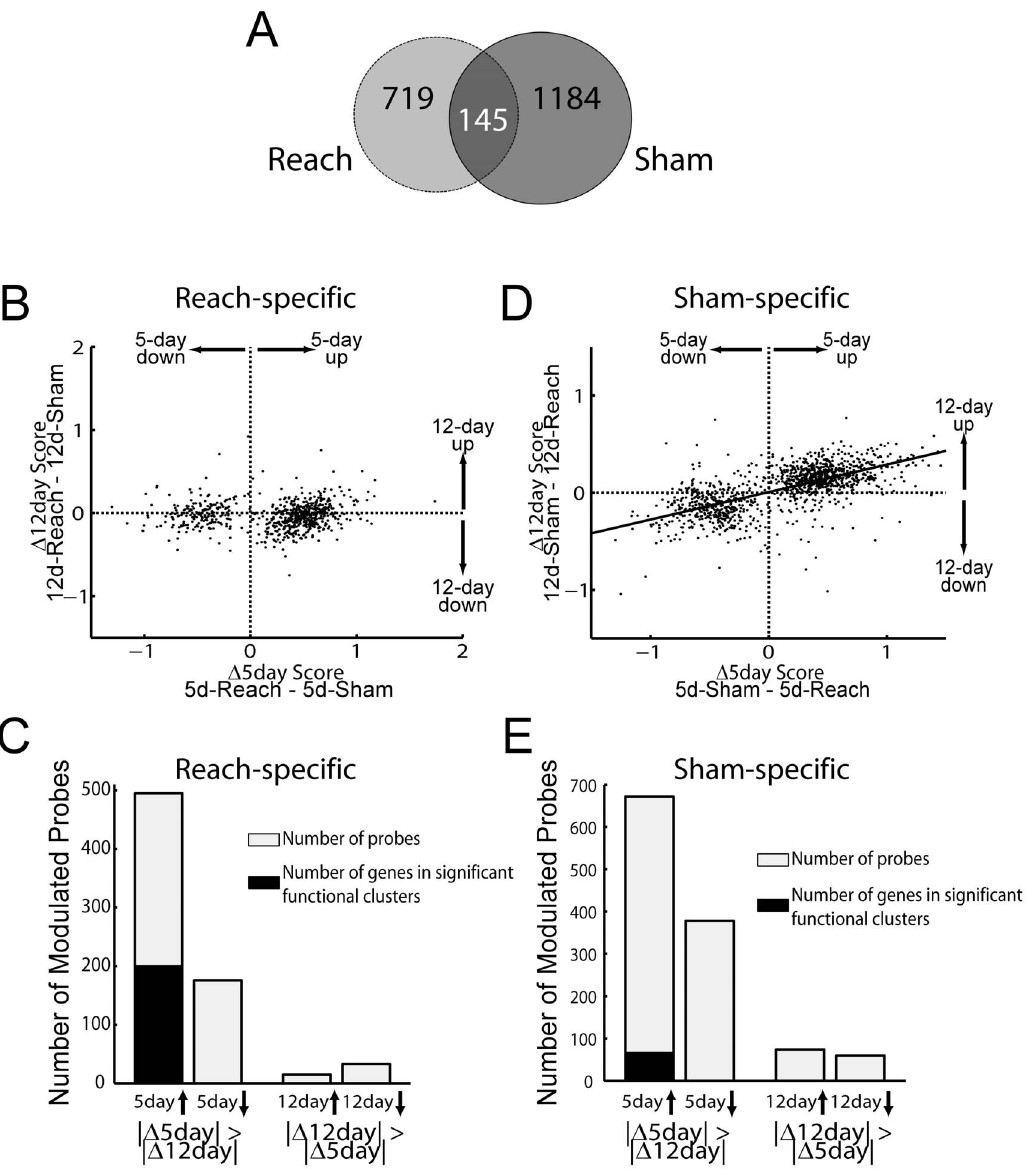
Figure 6. Most of the modulated probes in the Reach groups were differentially expressed at 5, but not 12, days. A , Isolating differentially expressed probes related to motor skill learning. The Venn diagram shows the degree of intersection between the set of modulated probes (Kruskal-Wallis test; p , 0.05) in the 0-day vs 5-day-Reach vs 12-day-Reach comparison (light grey circle), and that in the 0-day vs 5-day-Sham vs 12-day-Sham comparison (dark grey circle). The 1184 probes specific to the Sham groups probably reflect gene expression changes that occurred as a result of the execution of the task contingency, the passage of time, and other factors, while the 719 modulated probes specific to the Reach groups are most likely specifically related to processes underlying motor skill learning. B , Dynamics of differential gene expression from 5 to 12 days for the modulated probes specific to the Reach groups. For every modulated probe, the extent of differential expression at 5 and 12 days ( D 5day, x-axis; and D 12day, y-axis) were calculated by subtracting the mean expression of the Sham group of each day from that of the Reach group. A scatter plot of the 719 data points shown here revealed two distinct groups of probes clustering around the positive and negative D 5day-axes with relatively small amplitudes along the D 12day-axis, suggesting that most of the modulated probes were differentially expressed at 5 days but not at 12 days. C , Dynamic types of differential expression for the Reach -specific probes. Each modulated probe was grouped into one of the four dynamic types, depending whether | D 5day| was larger (bars 1 and 2) or smaller (bars 3 and 4) than | D 12day|, and whether the day with the larger magnitude of differential expression was an up- (bars 1 and 3) or down-regulation (bars 2 and 4). Most of the probes were grouped into the first and second types indicating a regulation at 5 days. The black bar indicates the number of genes up-regulated at Day 5 categorized into gene clusters in subsequent DAVID functional analysis. D , Dynamics of differential gene expression from 5 to 12 days for the modulated probes specific to the Sham groups. Unlike the Reach -specific genes shown in B , D 5day and D 12day for these probes showed a positive, significant correlation (p , 0.05). It is therefore possible that these Sham -specific modulations are driven by a process with a dynamics very different from that underlying forelimb skill learning. E , Dynamic types of differential expression for the Sham -specific probes. Notice that in the set of probes up-regulated at Day 5, the number of probes categorized into functional clusters by DAVID (black bar) was much smaller than that for the Reach -specific probes, shown in C .